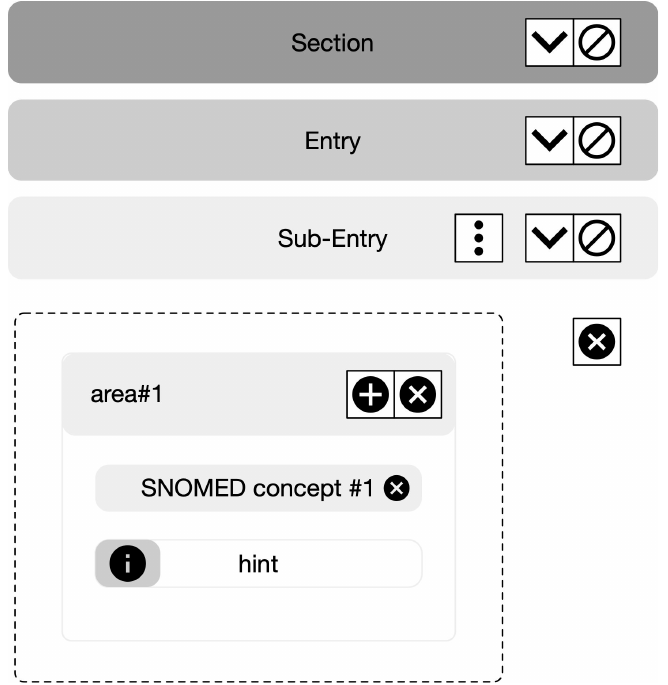
Figure 3. Mockup of the interface for template development. The HL7 CDA structure is graphically presented as follows: Section, Entry, and Sub-Entry are added to the template, as well as an area “area#1” with a single SNOMED-CT element “SNOMED concept”.